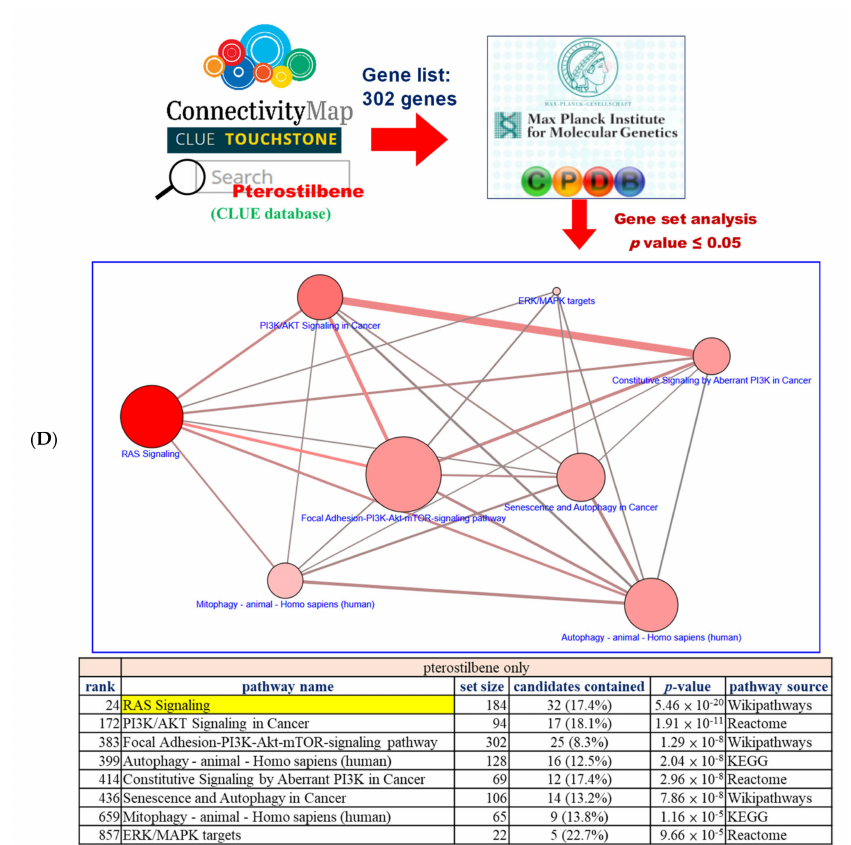
Figure 2. Pterostilbene was predicted to sensitize cisplatin-resistant bladder cancer cells by altering RAS-related autophagy and cell senescence pathways. ( A ) TP53 is the most common mutated gene found in patients with bladder cancer. GDC-TCGA (https: // portal.gdc.cancer.gov / ) is a cancer patient database containing information related to drug treatment, survival, and biospecimen sequencing that can be used to obtain data on clinical cases and to assist basic research. The data on gene mutation frequency among bladder cancer patients showed that the most prevalent gene was TP53 and almost 50% of patients with bladder cancer were characterized by the mutation. ( B ) The scatter plots show that the TP53 wild-type was more sensitive to cisplatin, suggesting that TP53 mutation may be one of the reasons for the resistance. Mutation of TP53 had no significant e ff ect on the sensitivity to gemcitabine or pterostilbene. The relationship between TP53 and the drug response was analyzed. The x -axis features TP53 . Each dot indicates a bladder cancer cell line. The blue dot denotes wild-type and the red dot denotes mutant. The y -axis is the cisplatin drug sensitivity score and the cuto ff is < 0.3 as indicated by the dashed gray line. Sensitivity to gemcitabine and pterostilbene was not significantly associated with TP53 characteristics (Mann–Whitney test, one-tailed). ** p < 0.01. ( C ) Pterostilbene overcame cisplatin resistance in bladder cancer. The bar chart illustrates the responses of bladder cancer cells to three separate drugs. T24 was the most sensitive cell line to pterostilbene but not resveratrol. HT1376 was cisplatin-resistant but sensitive to pterostilbene, suggesting that pterostilbene overcame the resistance. The cuto ff is < 0.3. ( D ) Potential mechanism of pterostilbene predicted using the C-Map and Library of Integrated Network-Based Cellular Signatures (LINCS) Unified Environment (CLUE) and ConsensusPathDB (CPDB) databases. The network shows the correlation among PI3K / AKT signaling, ERK / MAPK pathway, RAS signaling, and autophagy. The size of each dot denotes the entity number of genes in the pathway. The line between two dots was calculated by the function of these two pathways to indicate the number of genes overlapping said pathways. The breadth of the line denotes the strength of the correlation between two dots. The table lists detailed information on the pathway analysis from CPDB. The “set size” denotes the total members in the pathway and the “candidates contained” is the overlapping number between our input gene list and the pathway CPDB